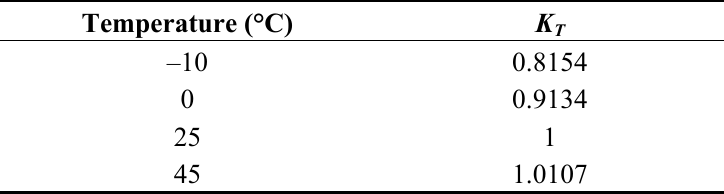
Table 1. The relationship between efficiency and